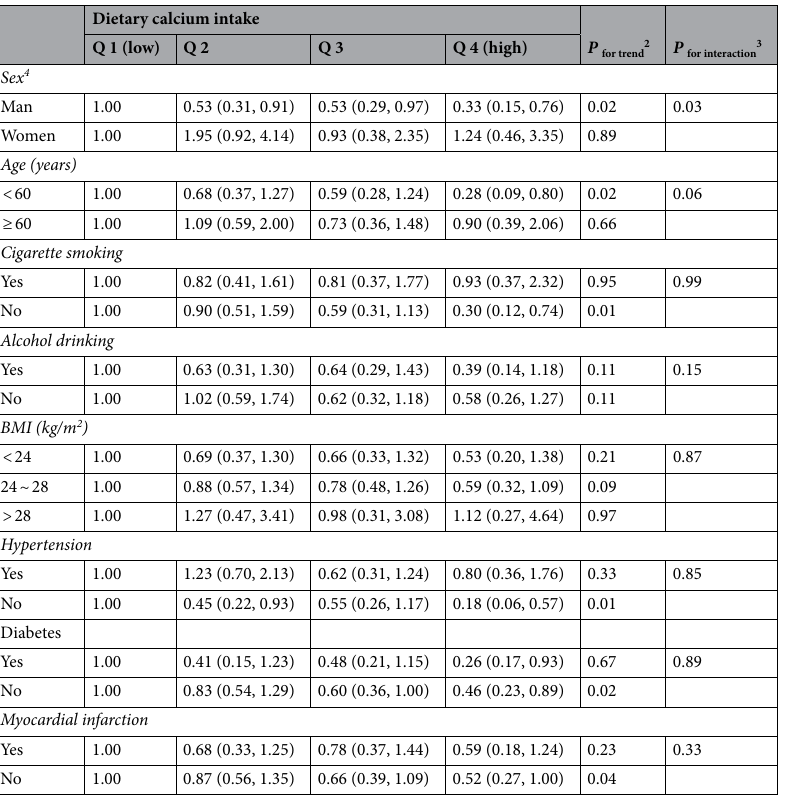
Table 3. Stratified hazard ratios (95% confidence intervals) 1 of stroke according to quartiles of dietary calcium intake by various characteristics of participants. 1 Covariates: age (continuous), sex (men/woman), urbanization index (low, medium, high), education (primary, secondary, college/university), household income (low, middle, high), smoking status (yes/no), alcohol intake (yes/no), physical activity levels (light, moderate, vigorous), BMI (< 24, 24–28, or > 28 kg/m 2 ), hypertension (yes/no), diabetes (yes/no), myocardial infarction (yes/no), medication use (yes/no), energy, whole grain, red meat, fruits, vegetables, saturated fat, polyunsaturated fat, cereal fiber, Na, K and cholesterol intakes (continuous), except for the stratifying variables per se. 2 P for trend values were calculated by modeling the median of each quartile-defined category as a continuous variable in the model. 3 P for interaction values were calculated using the likelihood-ratio test. 4 In the stratified analysis, characteristics of participants at baseline were used for stratification and